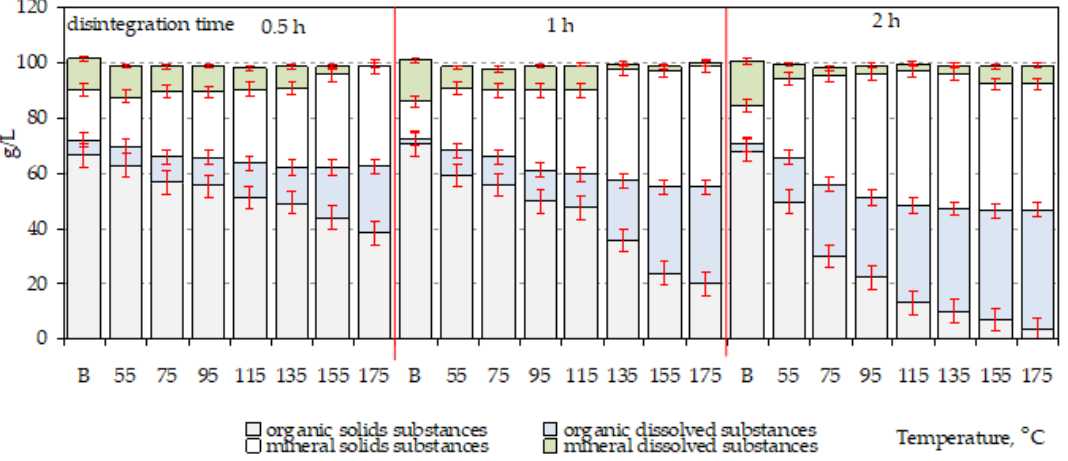
Figure 1. Changes in the concentration of the total suspension and in substances dissolved in bio-waste and hydrolysates, depending on the temperature and duration of disintegration.